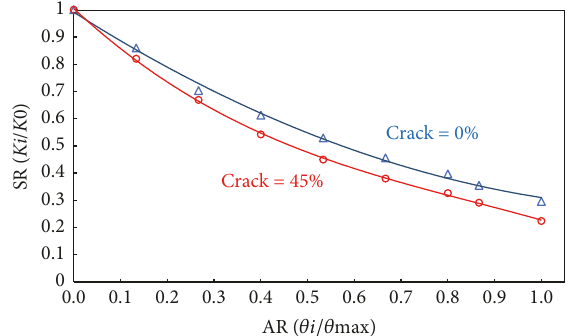
Figure 11: Stiffness ratio (SR) versus angle ratio (AR) for 0% and 45% CLP for the